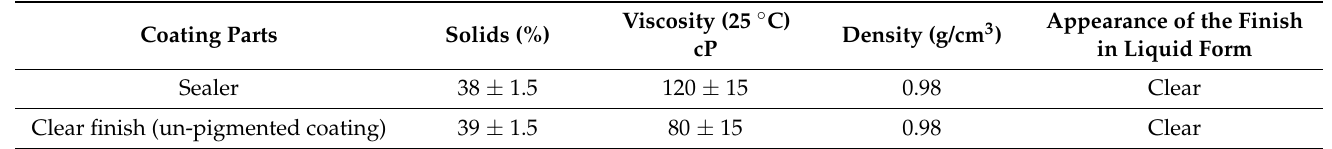
Table 1. Specifications of the sealer–clear finish used in this research work. Viscosity (25 ◦ C) Appearance of the Finish Coating Parts Solids (%) Density (g/cm 3 ) in Liquid Form Sealer Clear Clear finish (un-pigmented